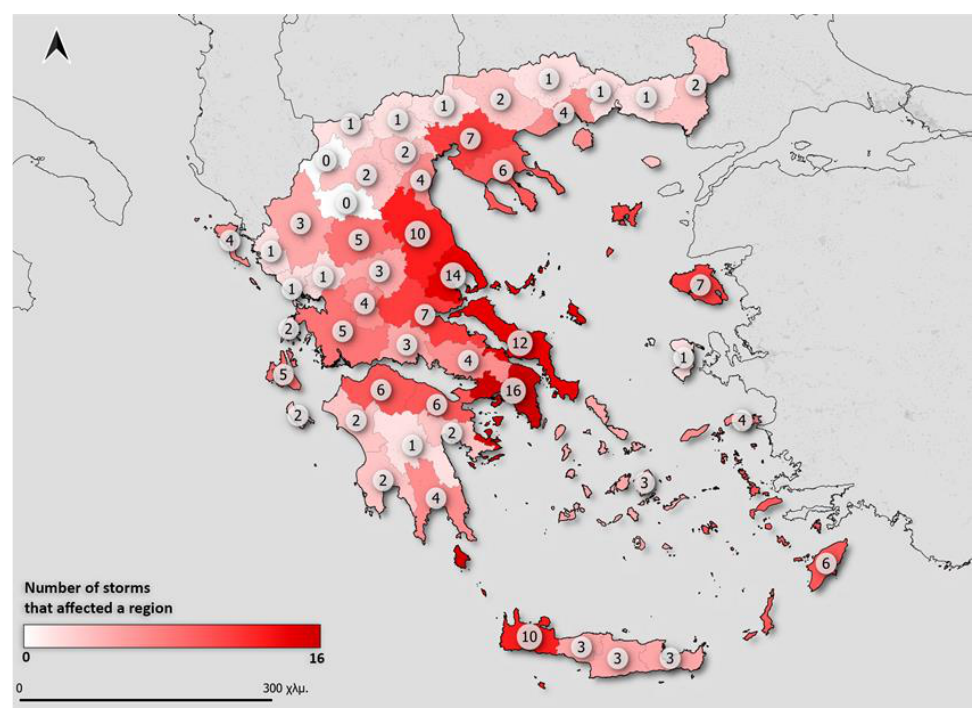
Figure 9. Number of named storms that affected each prefecture in Greece during the period January 2017–September 2021.